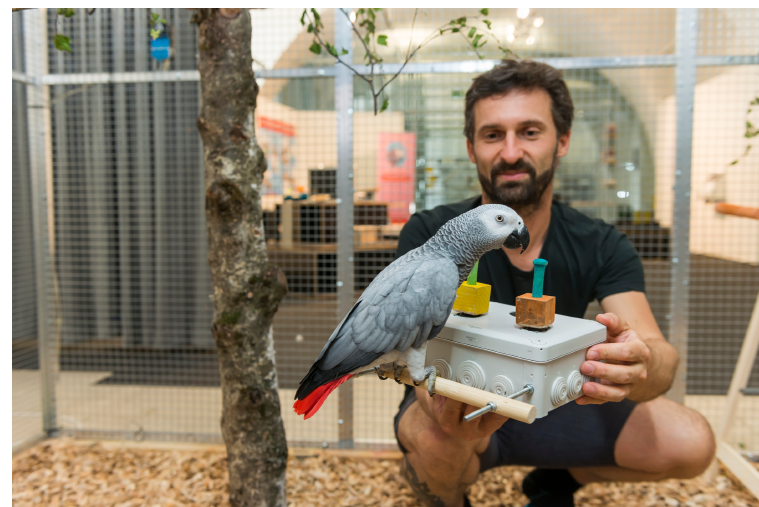
Figure 5. metamusic , joystick device [37].